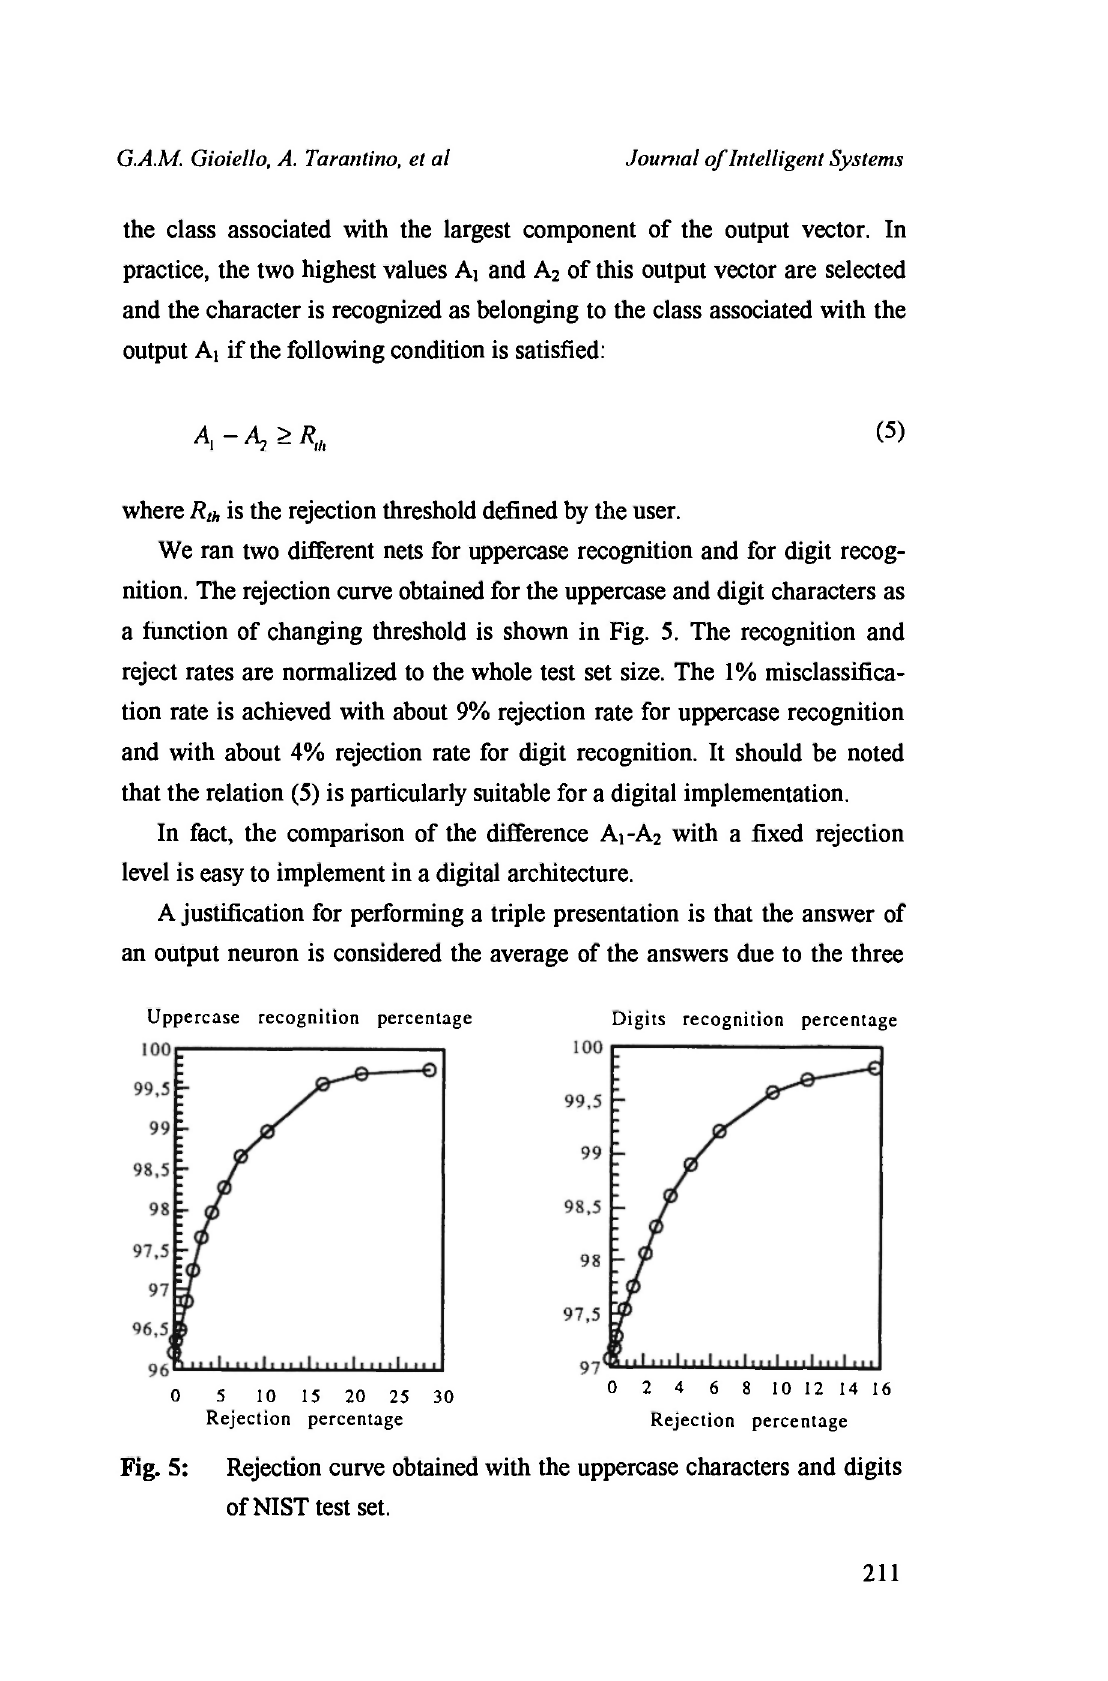
Fig. 5: Rejection curve obtained with the uppercase characters and digits of NIST test